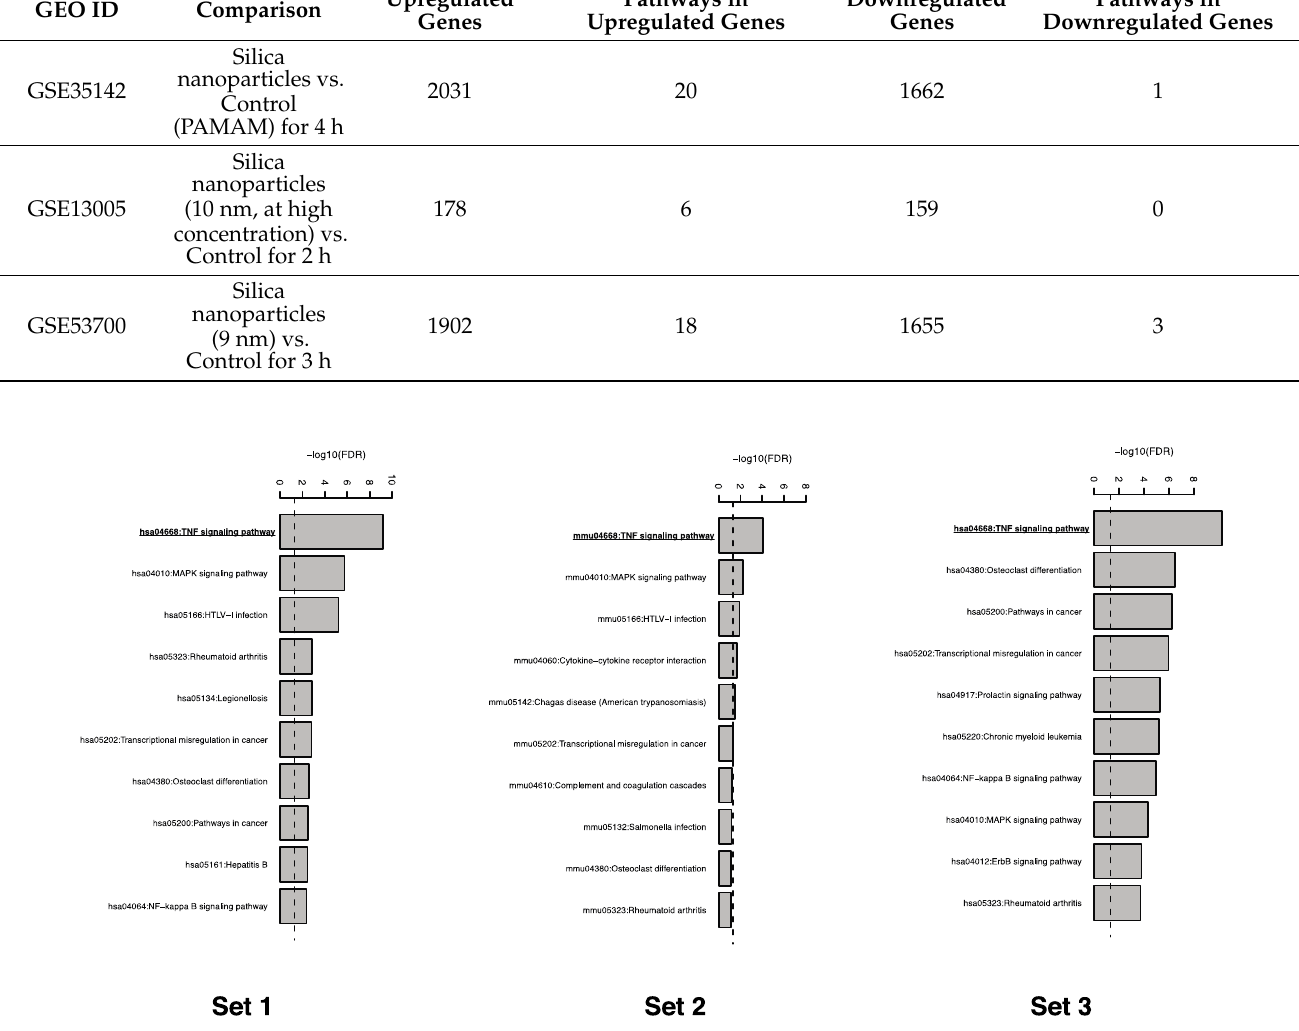
Figure 2. Top 10 enriched pathways identified from up-regulated genes in three microarray datasets.